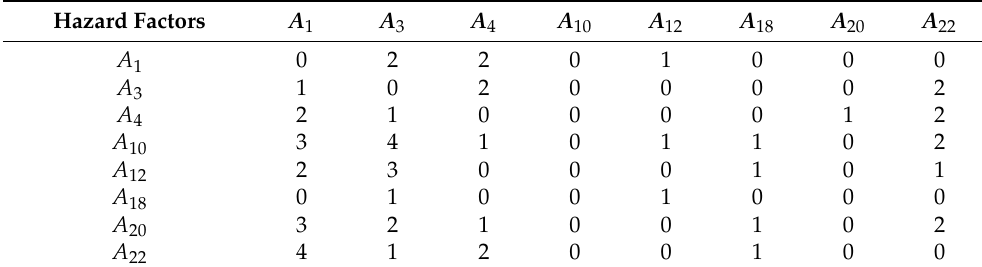
Table 10. Direct influence matrix of the hazard in the grid G H .